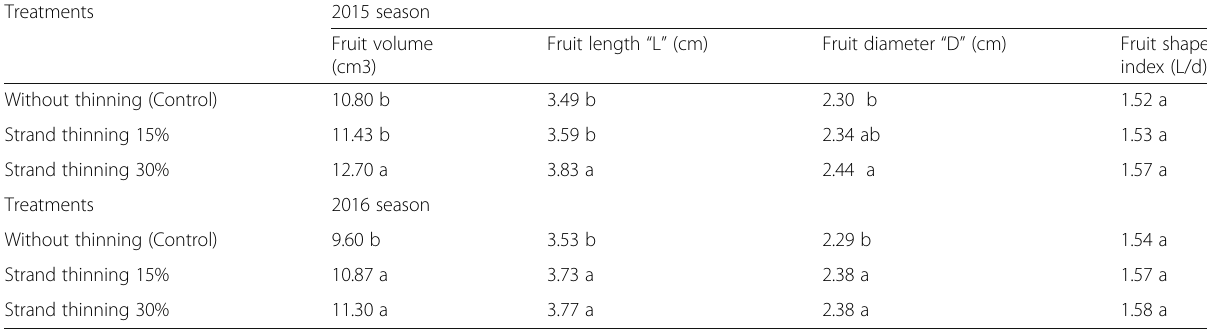
Table 3 Effect of strand thinning treatments on fruit volume, fruit length, fruit diameter and fruit shape index of Khadrawi date palm cultivar at rutab stage during 2015 and 2016 seasons Treatments